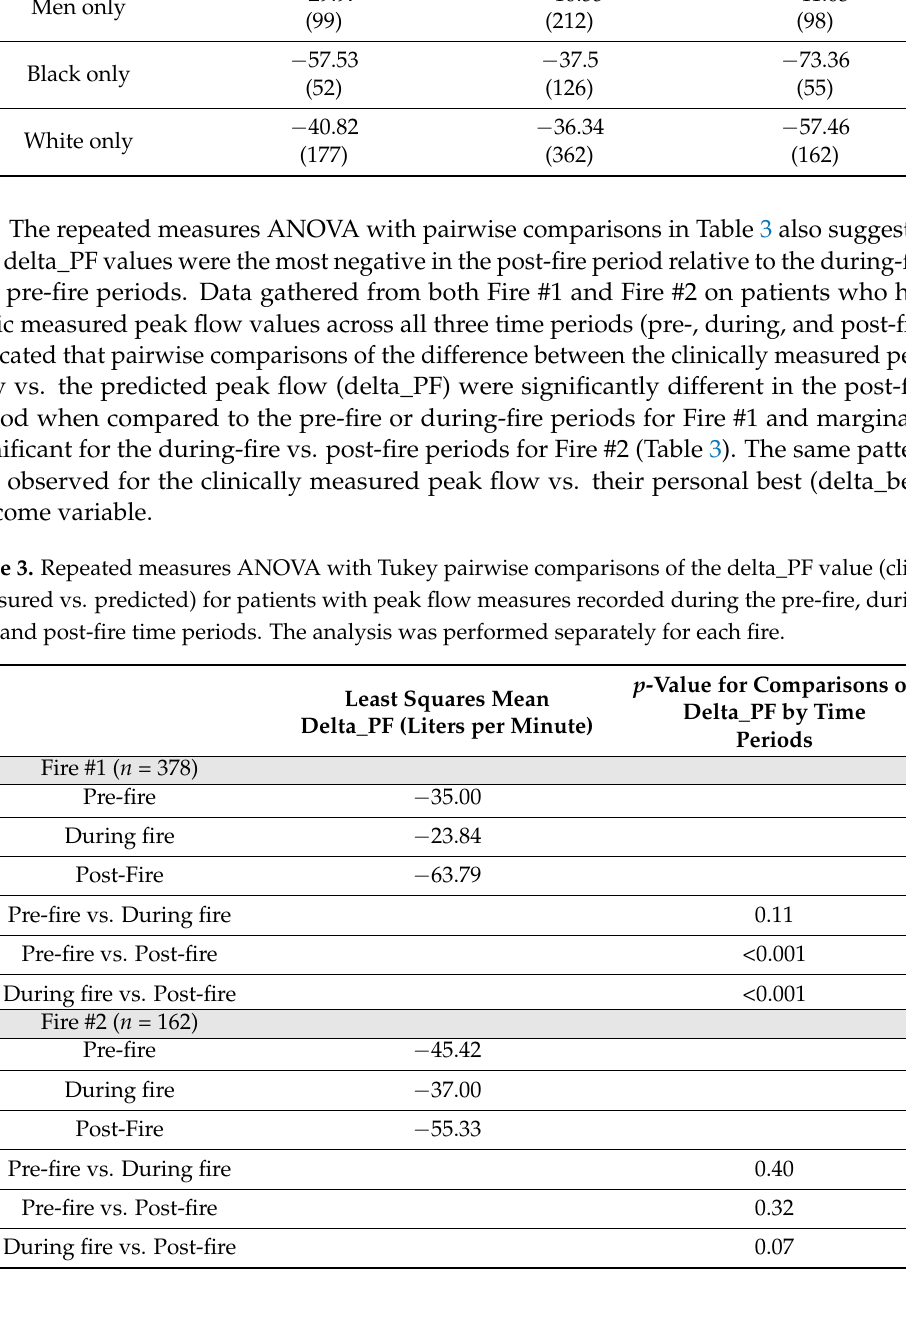
Table 2. Average clinic measured difference (delta_PF) in peak flow (L/min) from predicted peak flow for Fire #1 across all time periods (pre-fire, during fire, post-fire) for specific groups of patients with allergic rhinitis and/or asthma. See Figure 1 for dates of each period. Pre-Fire Period During-Fire Period Post-Fire Period Average Delta_PF